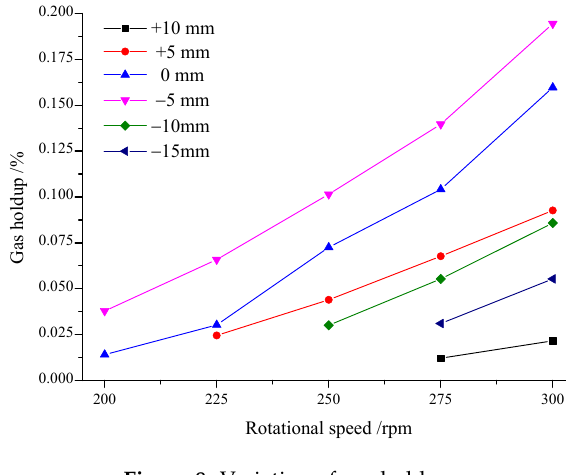
Figure 8. Variation of gas holdup.